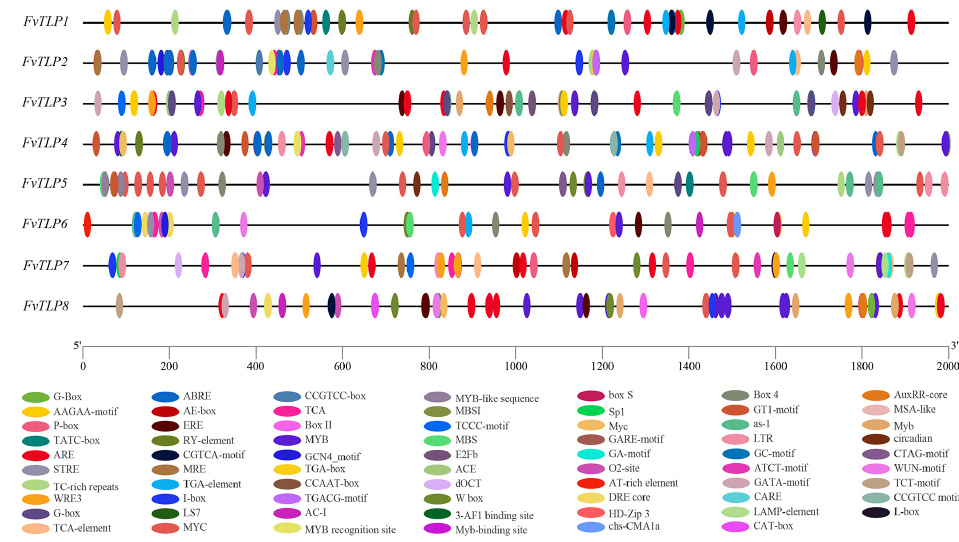
Figure 2. Conserved motif composition of FvTLPs and gene structure of FvTLP s. Distribution of conserved motifs in FvTLPs (left) and intron–exon structures of FvTLP genes (right). Rectangles of different colors represent different motifs, blue rectangles represent UTRs, black lines represent in ‐ trons, and ginger rectangles represent exons.